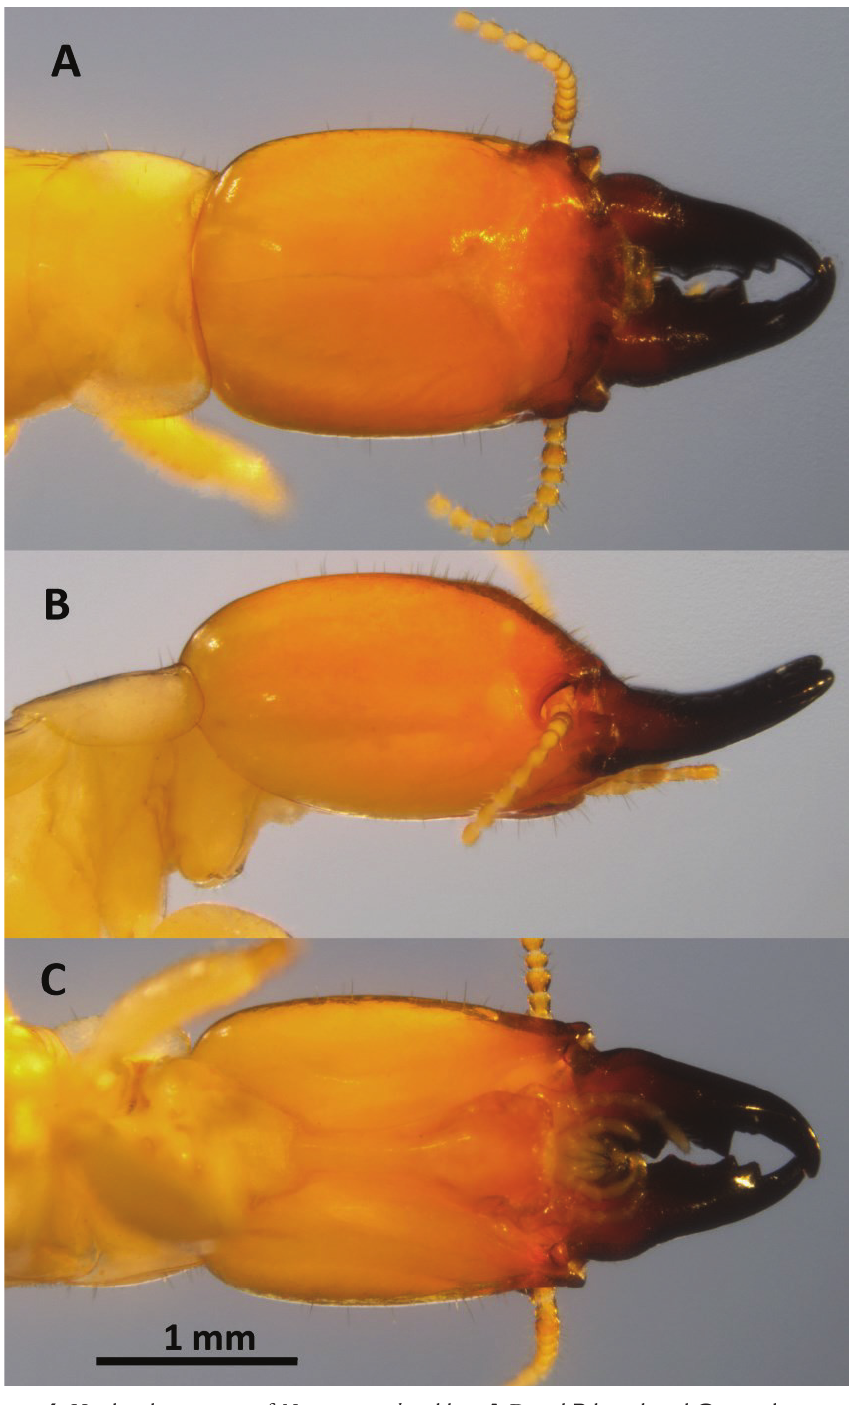
Figure 6. Head and pronotum of Neotermes agilis soldier . A Dorsal B lateral, and C ventral